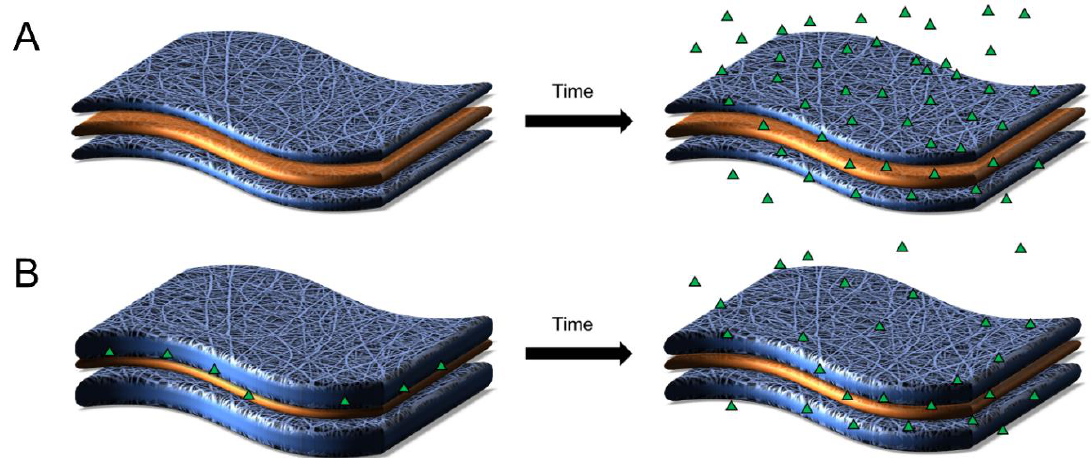
Figure 5. Schematic of anticipated active agent release from multilayered fibers. One method to modulate the release of active agents (shown in green) is to vary the thickness of the outer layer (shown in blue). ( A ) A thin outer layer provides both rapid burst release and limited sustained-release of encapsulants. ( B ) In contrast, increased outer layer thickness can delay the release of some active agents.